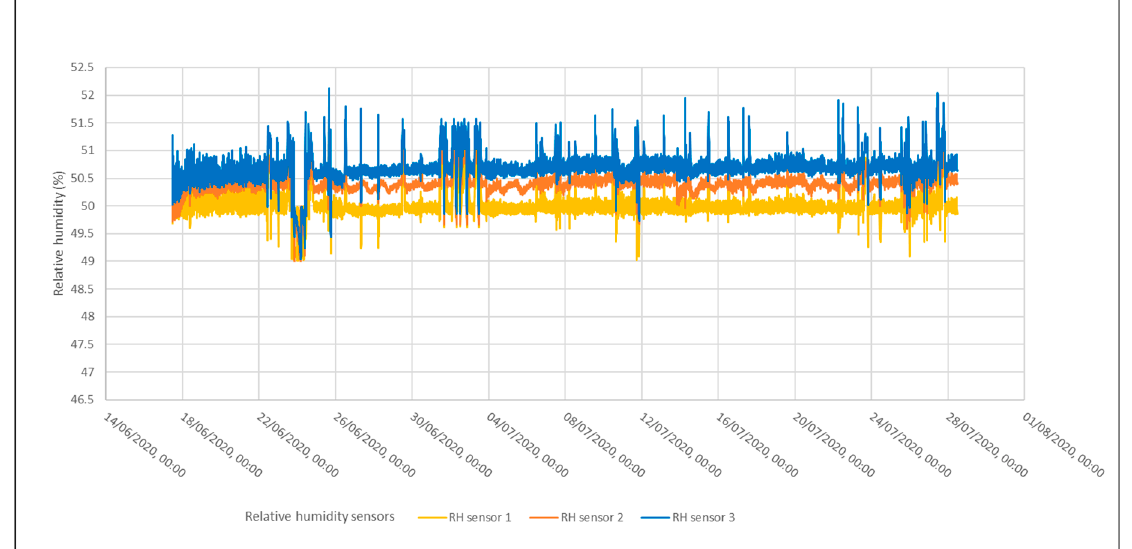
Figure 22. Relative humidity profile of the room aimed at 50% for the testing period 2.